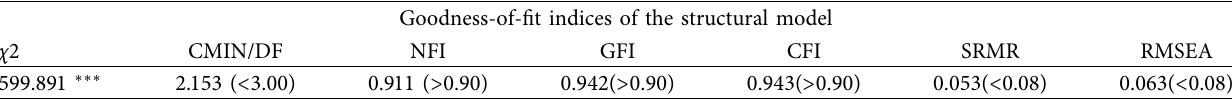
Table 6: Goodness-of-fit indices of the structural